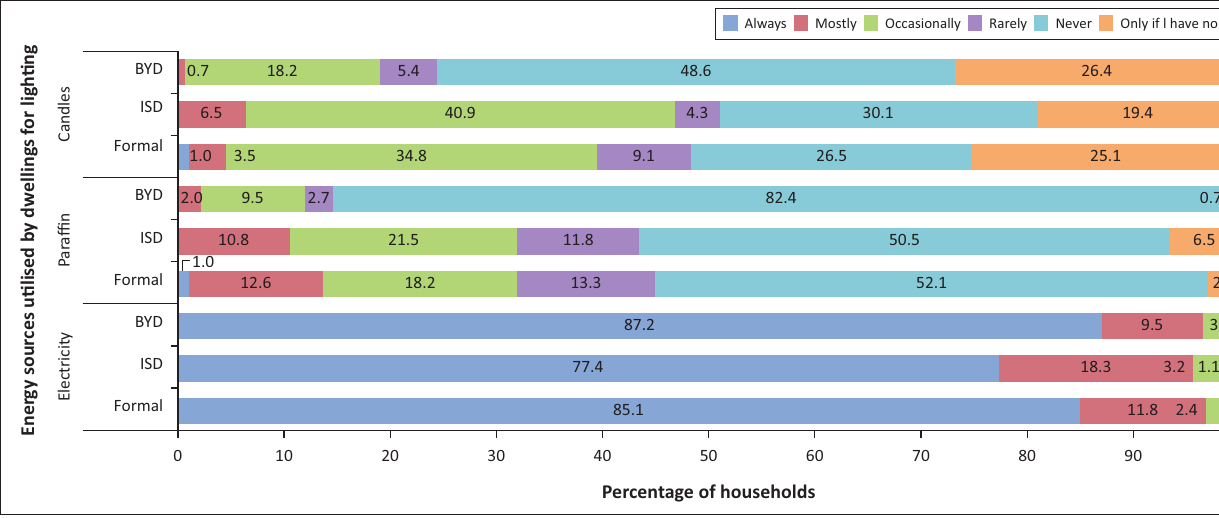
FIGURE 6: Energy sources used for lighting by households.